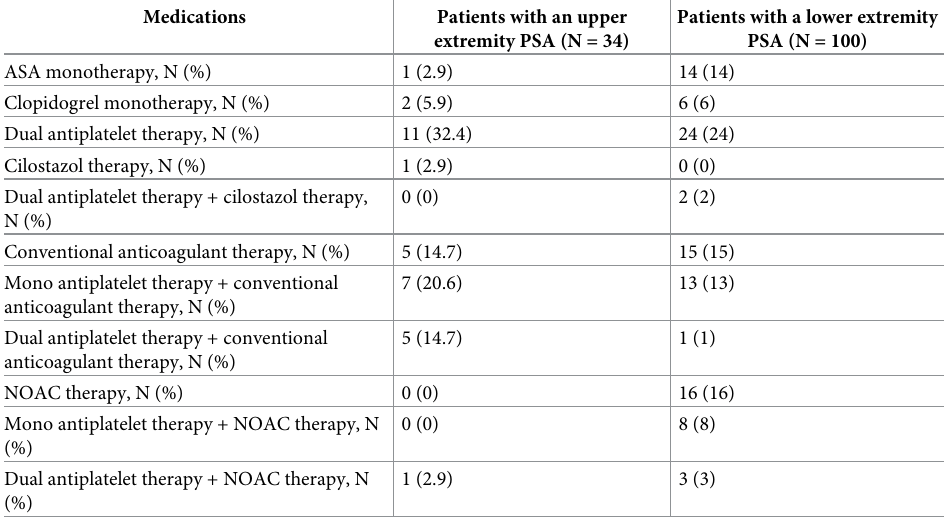
Table 2. Medication regimen of patients with a